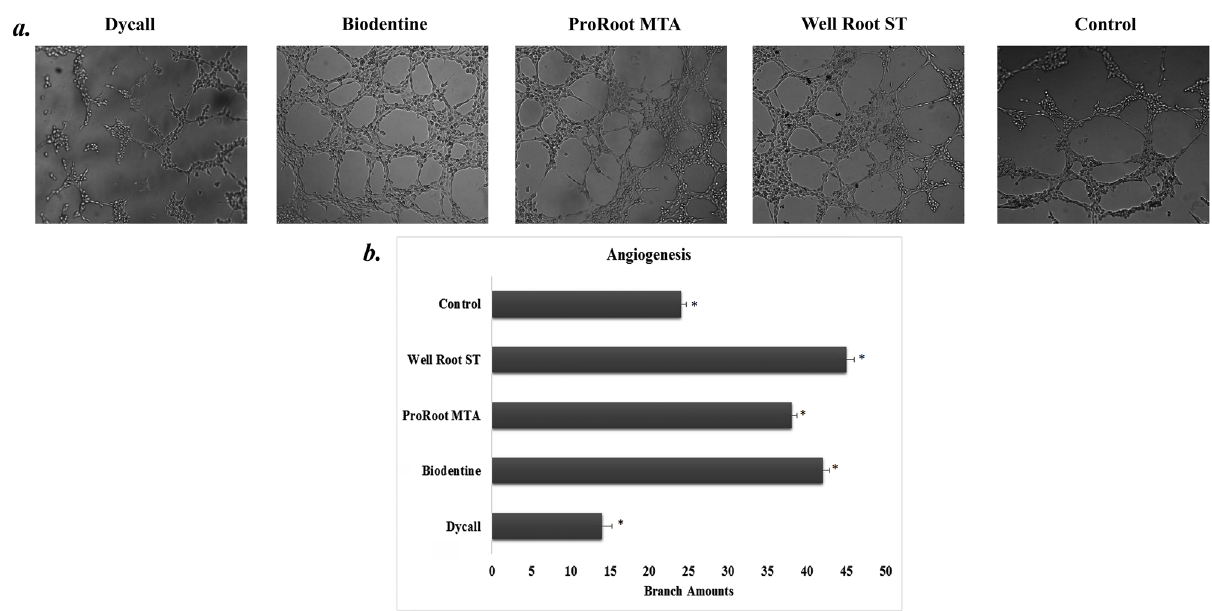
Figure 6- (a) Tubular network formation of HUVEC cells on Matrigel. Representative images showing tubular network formation at 6-8 hours after cell seeding (100,000 cell/50 μL with serum-free DMEM). The groups showed tubular network formation as follows, respectively: Well-Root ST>Biodentine>ProRoot MTA>Control>Dycal (p<0.05). HUVECs: human umbilical vein endothelial cells; DMEM: Dulbecco's modified Eagle's medium. (b) Quantitative analysis of angiogenic tubule formation. Comparison of parameters of tube formation assay among tested materials (Significant: